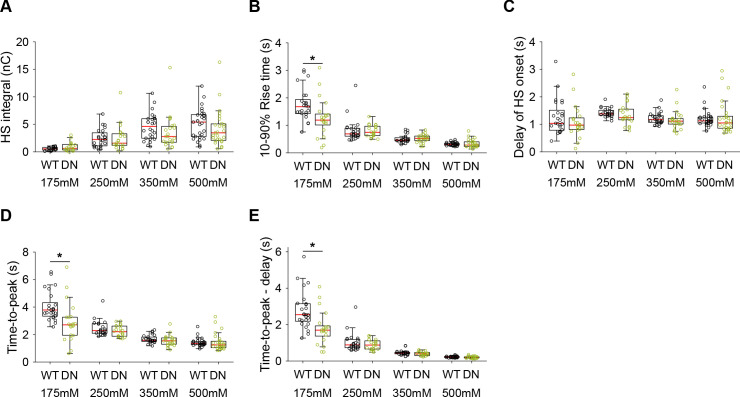
Additional HS parameters from Syt1 WT and Syt1 D232N expressing neurons.(A) Integral of current from HS-induced release at different concentrations. (B) 10–90% rise time of peak HS-induced current. (C) Time delay after application of HS before onset of release. (D) Time from start of HS application till peak HS-induced current. (E) Time from start of HS application till peak HS-induced current, corrected for the delay in release onset after HS application. All panels comparing Syt1 WT and Syt1 D232N (*p<0.05, Wilcoxon rank sum test).
Figure 3—figure supplement 1—source data 1.Statistics overview.